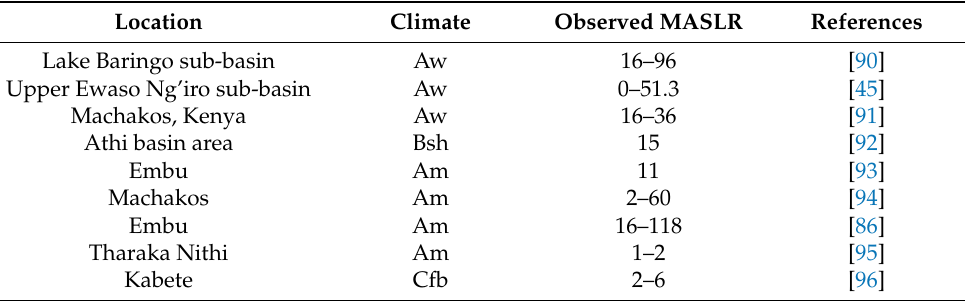
Table 18. Mean soil erosion rates (t ha − 1 yr − 1 ) from previous plot studies within Kenya.